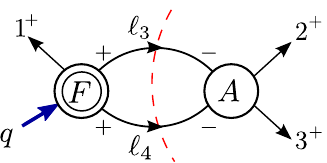
Figure 4 . A double cut of the two-loop minimal form factor of O S ; O C | the case of a one-loop form factor joined to a tree-level